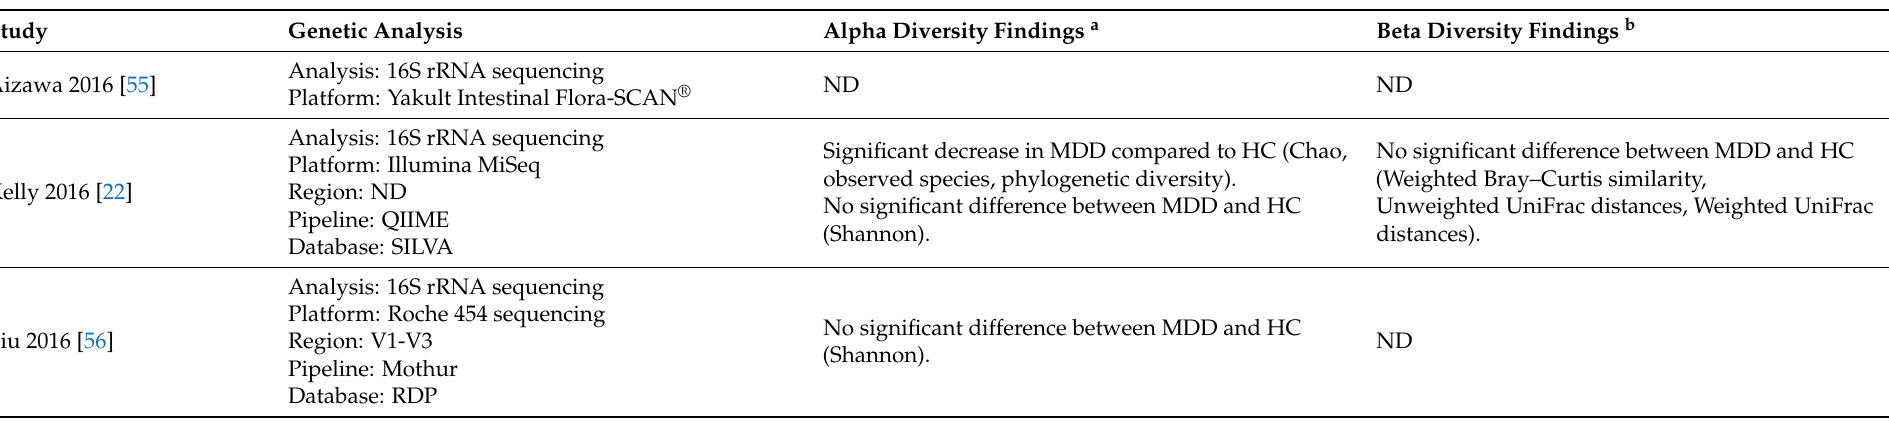
Table 2. Alpha diversity and beta diversity changes observed in patients with major depressive disorder relative to healthy controls in the observational